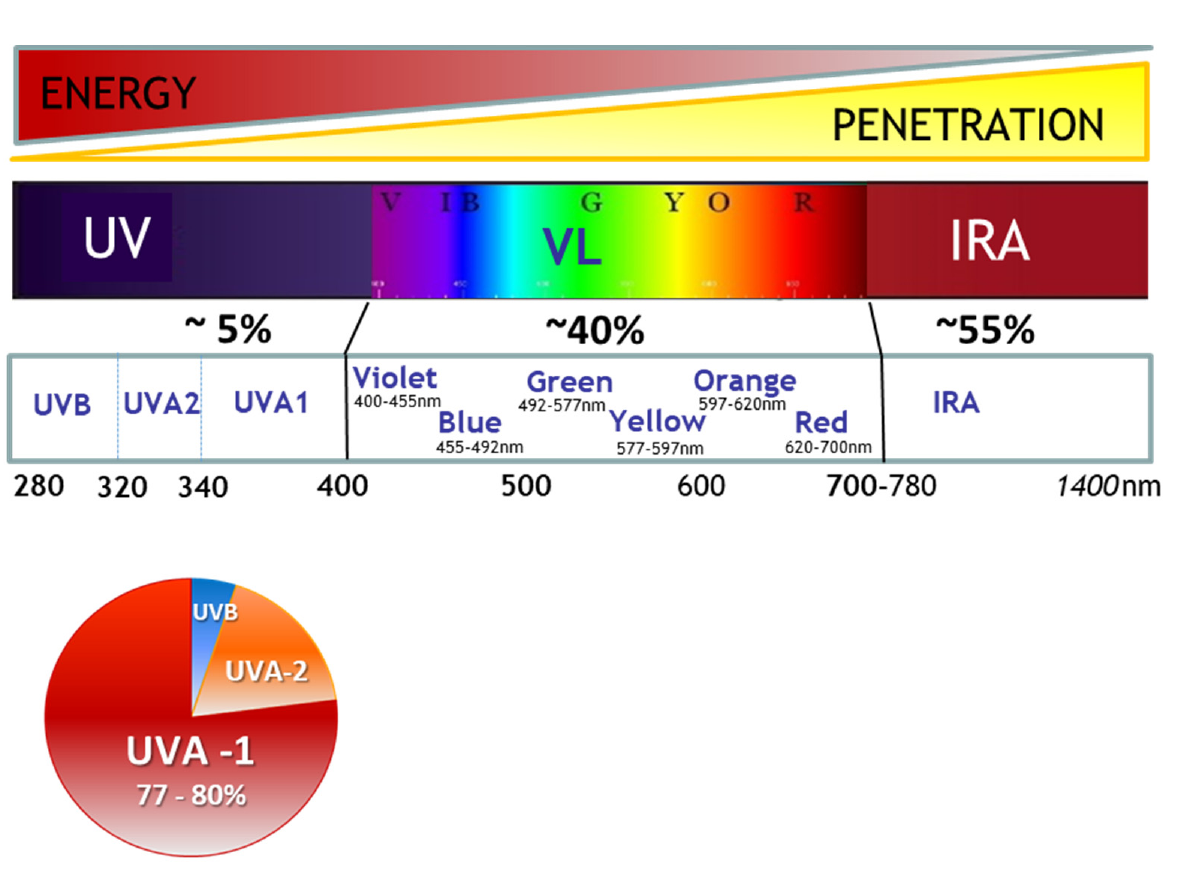
Figure 1. Solar spectrum. The three wavelength ranges along the solar radiation spectrum that are relevant for their impact on skin are ultraviolet (UV), visible light (Vis) and Infrared A (IRA). Energy and penetration properties are respectively lower and higher with increasing wavelengths. In the UV wavelengths domain UVA1 (long UVA), 340–400 nm can represent up to 80% of the total UV rays (for example, in the winter in temperate zones). UV: ultraviolet; IRA: Infrared A.